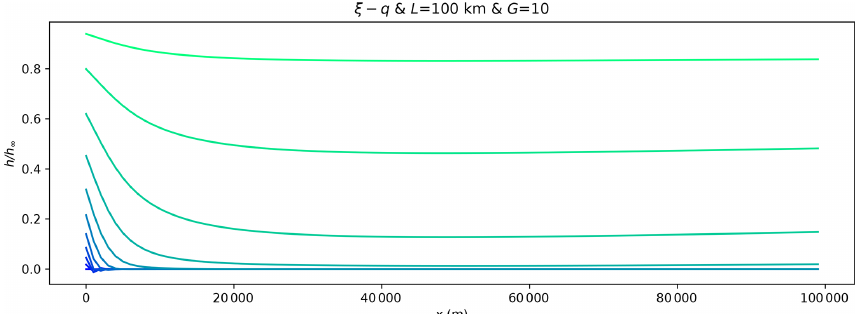
Figure 16. Evolution of the sedimentary system for L > L 0 using the ξ – q model but a value of G = 10. The solution looks very similar to that obtained by using the TL model (Fig.